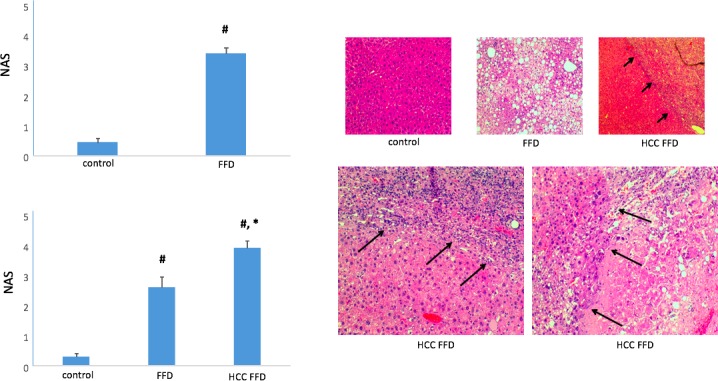
Liver histopathology.(Top left) At 3 mo on the diets, NAS was elevated in the FFD cohort vs. the control diet cohort (#, p < 0.01 vs. control). (Bottom left) At 14 mo on the diets, NAS was elevated in the FFD cohort vs. the control diet cohort (#, p < 0.01 vs. control). Animals exhibiting liver tumors (HCC FFD) exhibited highest NAS (*, p < 0.01 vs. FFD). (Top right) Representative H&E stained liver sections (10 X) from the 14 mo control, FFD and HCC FFD cohorts are shown. Steatosis was prominent in the FFD cohort. tTe HCC FFD cohort showed a trabecular growth pattern of atypical hepatocytes and clusters of multinucleated hepatocytes with a distinct margin (arrows) between the cancerous and non-cancerous parenchyma. (Bottom right) Representative H&E stained liver sections (20 X) from HCC FFD livers showing aspects of NASH (steatosis and inflammation) and HCC (arrows).